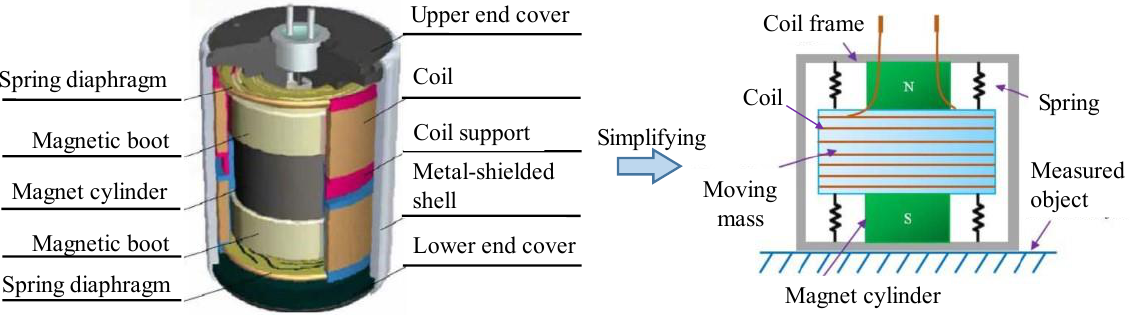
Figure 7. Conventional magnetoelectronic velocity sensor and its simplified model [37].